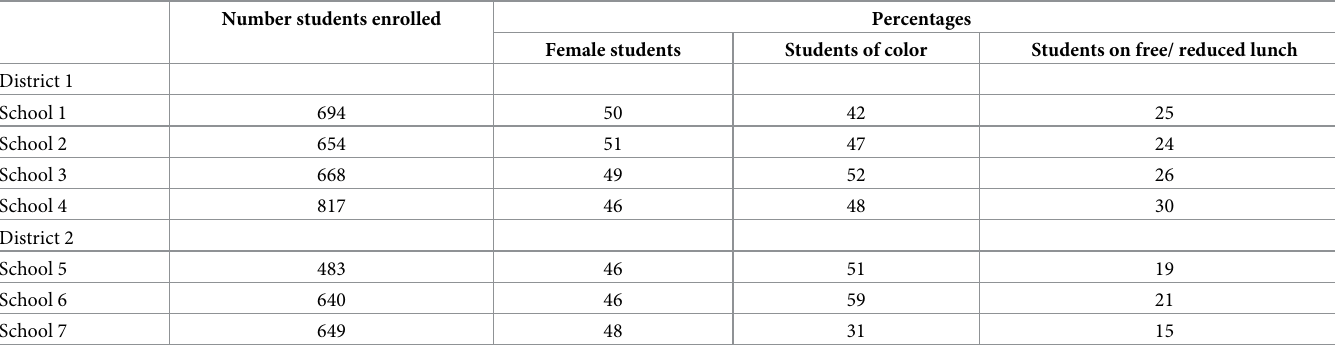
Table 1. Sociodemographics of students at middle